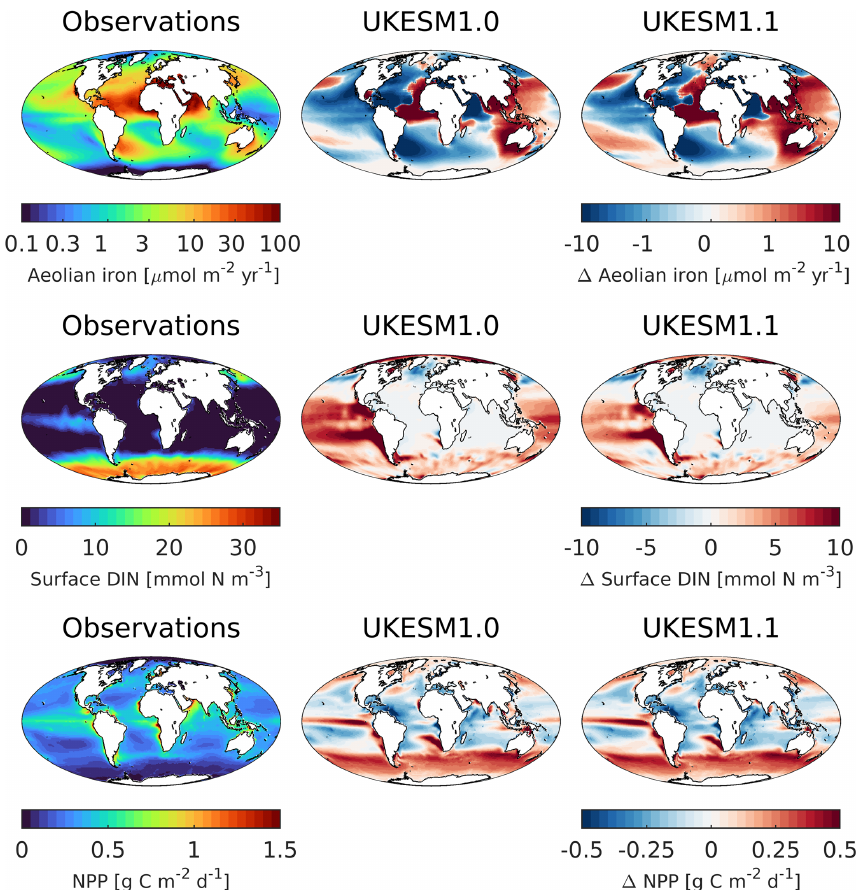
Figure 16. Spatial distributions of (left) observed (top) iron deposition to the ocean (middle row), dissolved inorganic nitrogen (DIN) and (bottom) net primary production (NPP), along with simulated biases from (middle column) UKESM1 and (right) UKESM1.1.